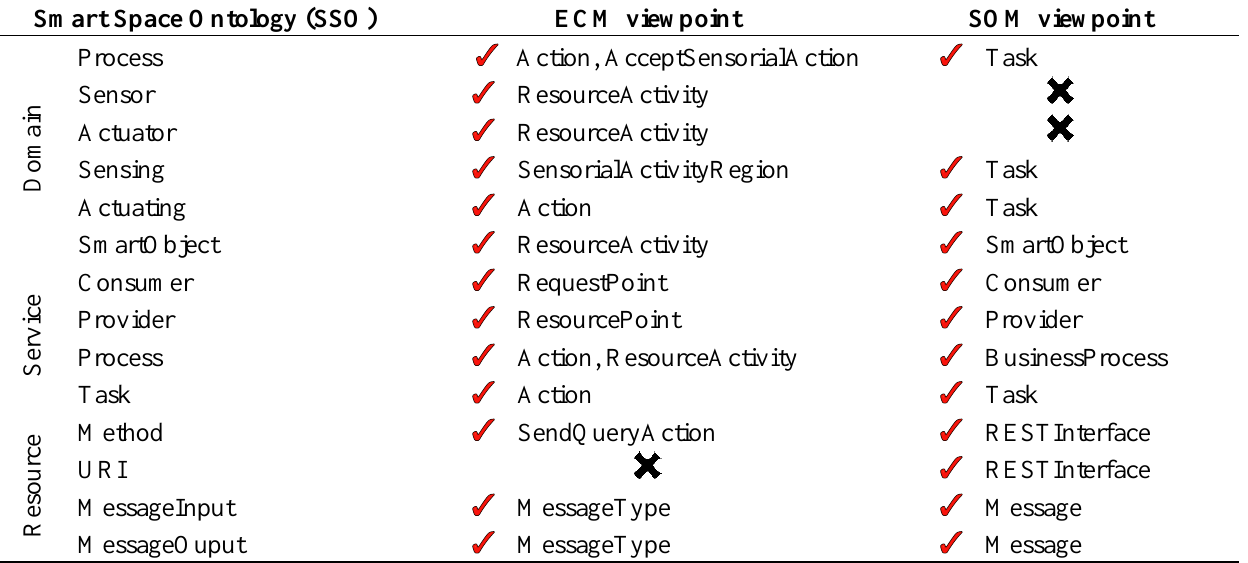
Table 6. Traceability matrix indicating relationships between concepts in SSO and entities in ECM and